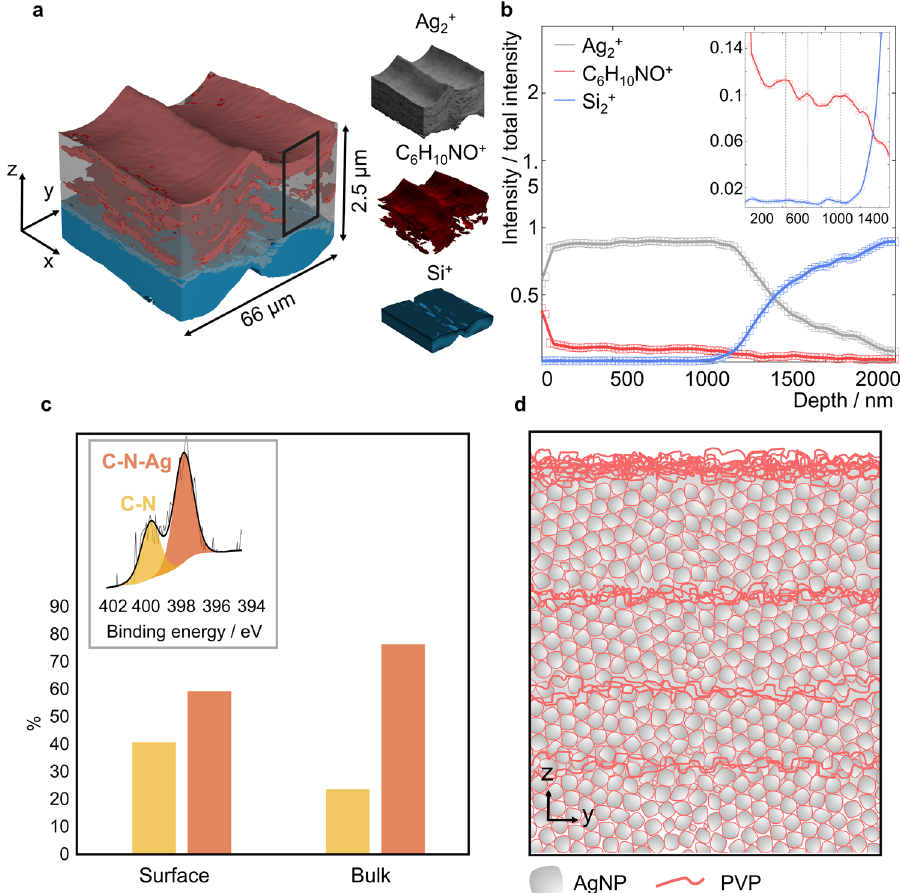
Fig. 2 3D chemical analysis of four stacked layers of inkjet 3D printed AgNPs. a 3D rendering of ToF-SIMS signal for Ag 2 + , C 6 H 10 NO + and Si + . b Depth pro fi le (averaged over an area of 50 × 50 µ m 2 per depth level) showing accumulation of PVP at layers interface. c XPS N1 s data for non-interacting, free (C – N, 400 eV) and interacting (C – N – Ag, 398 eV) PVP with the Ag surface on top surface and bulk (~100 nm deep). d Illustration of cross-section of stacked AgNPs layers with PVP-rich